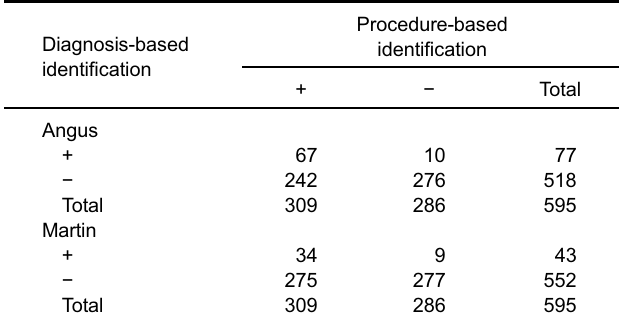
Table 6. Comparisons between diagnosis- and procedure- based identi fi cations Diagnosis-based identi fi